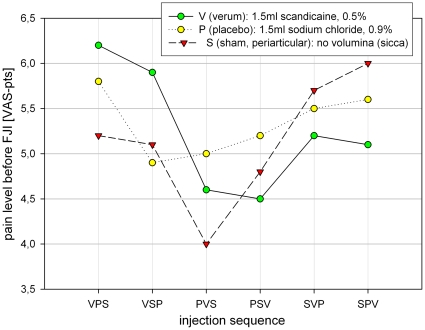
Carry over effect in sequences.